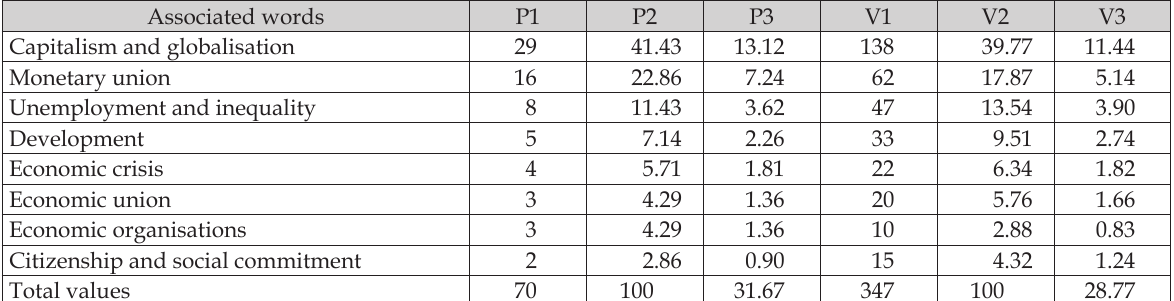
Table 4. Categories shaping the semantic field on social and economic realities and social interpretations after the associated word test on students in training to be teachers in secondary